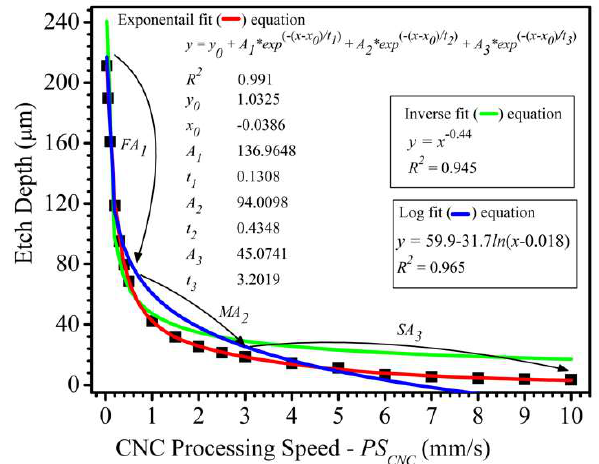
Figure 5. A plot showing an inverse (green trace), logarithmic (blue trace) and a three-phase exponential decay (red trace) dependence of etch depth on CNC processing speed (PS CNC ). All processing parameters were kept constant, including average laser fluence (LF av ) at 329.06 J / cm 2 . Approximate portions of the plot that shows fast, medium, and slow exponential decays are represented by FA 1 , MA 2 , and SA 3 , with pre-exponential decay factors of 136.9648, 94.0098, and 45.0741 µ m, respectively. Legend—experimental data points: black squares, inverse data fitting: green trace, logarithmic data fitting: blue trace, exponential data fitting: red trace.